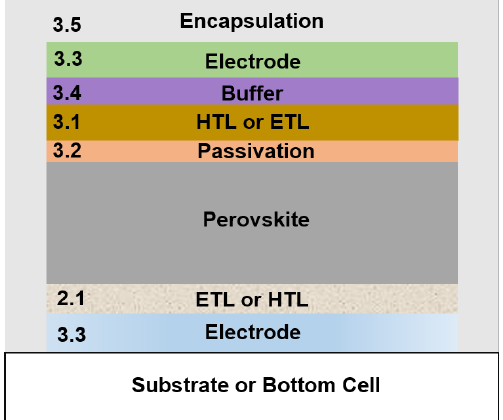
Figure 1. Schematic graphic for the overall concept in the application of atomic layer deposition (ALD) in perovskite solar cells (PSCs). The corresponding section numbers in this review are denoted for the incorporation of ALD for each